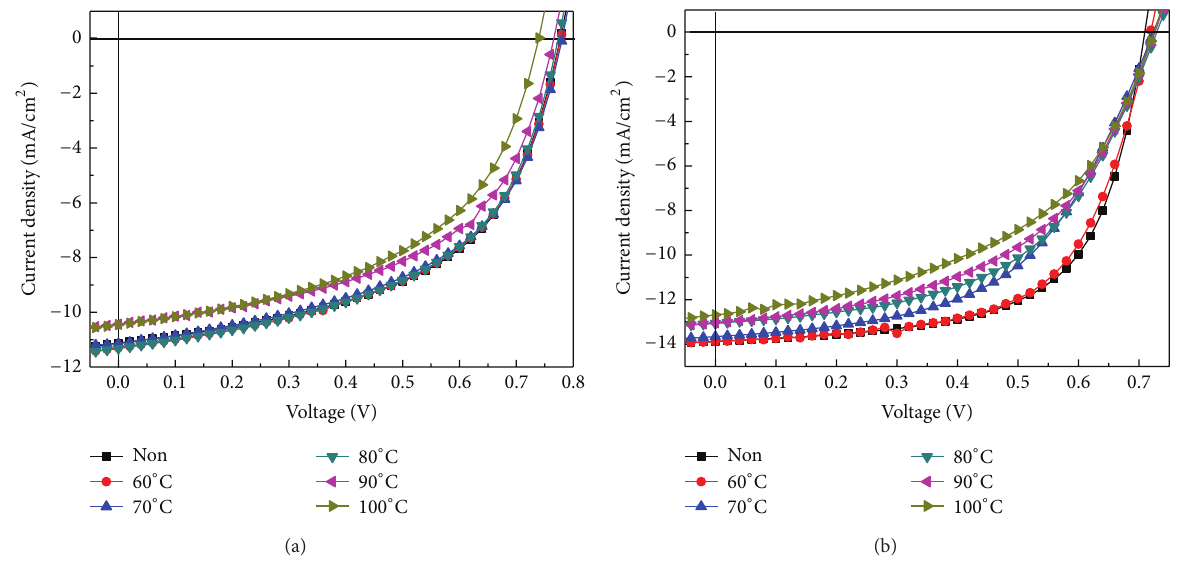
Figure 1: The J-V curves of the OPV devices with the PBDTTT-C:PC 71 BM layers (a) without and (b) with DIO heated under different temperatures for 5 minutes.